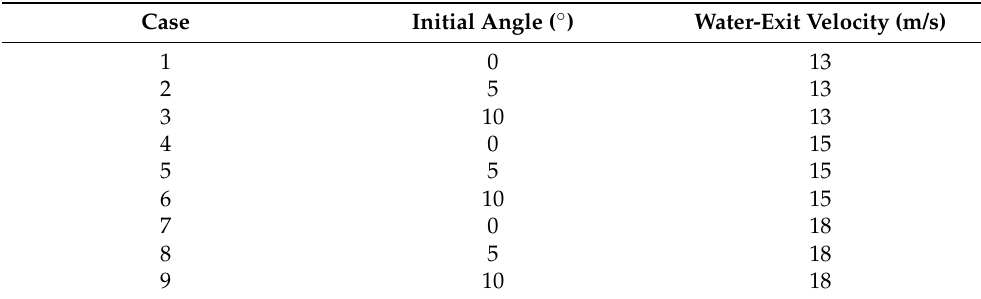
Table 1. Calculation